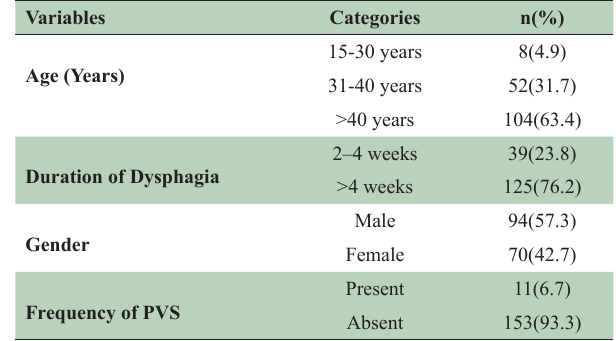
Table-I: Participant characteristics